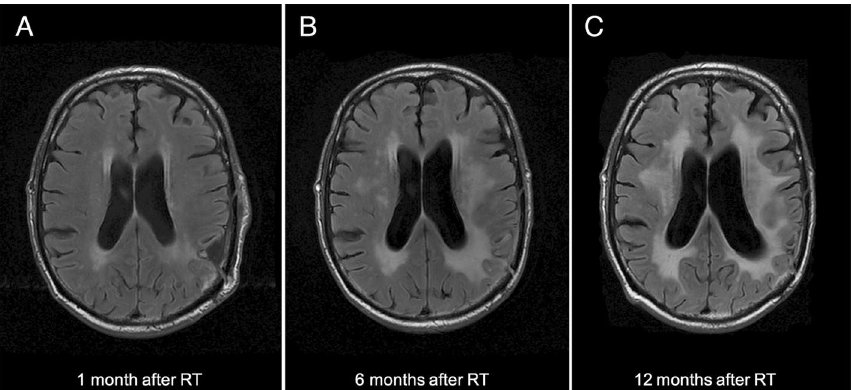
Figure 1. MRI findings of radiation-induced neurotoxicity presenting as rapidly progressing white matter hyperintensities associated with cortical and subcortical atrophy. The images show MRI findings at 1 month ( A ), 6 months ( B ) and 12 months ( C ) after RT. The patient received 60 Gy in 30 fractions with concomitant TMZ for a left parietal glioblastoma. After 1 year of follow up, memory deficits were present (MOCA 13/30) as were gait difficulties and urinary incontinence. The patients had the rs2120825 risk allele T (TG).